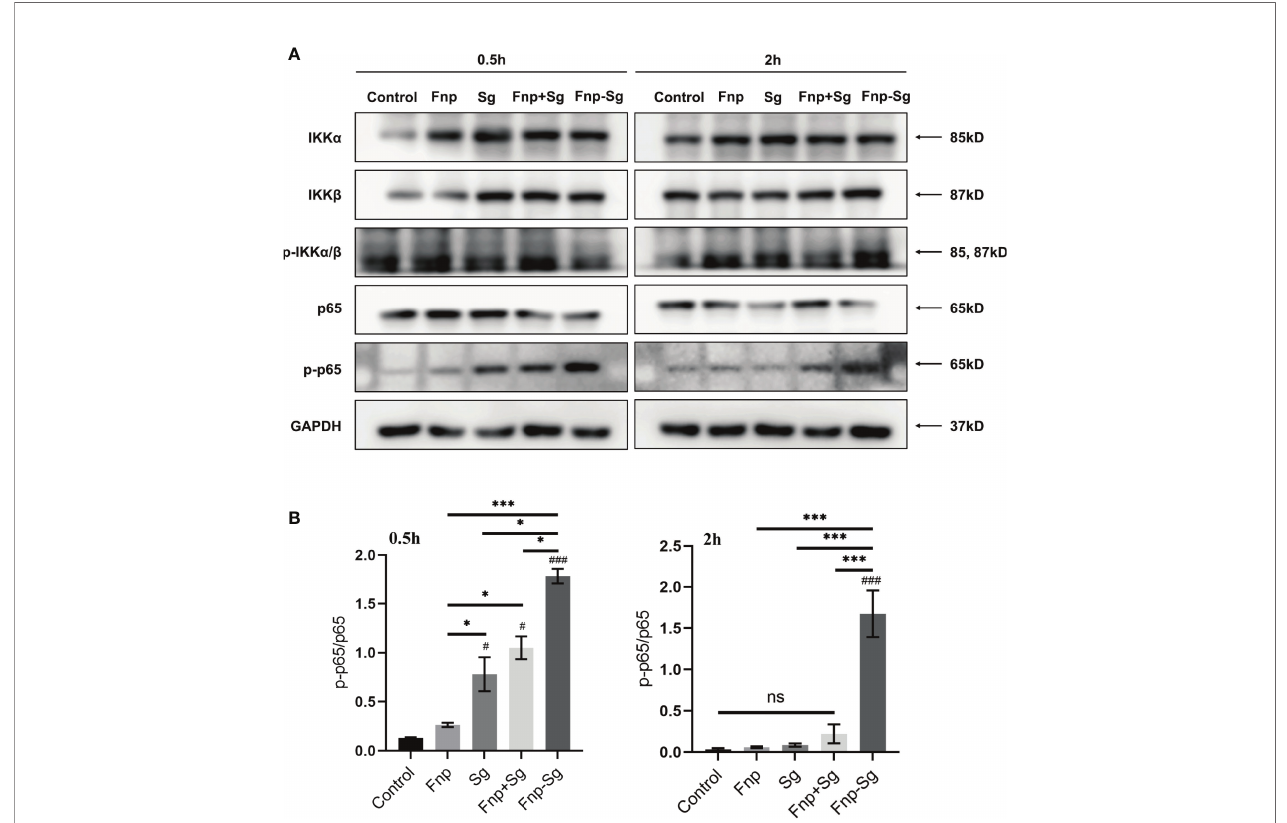
FIGURE 8 | The phosphorylation levels (A) and semiquantitative analysis (B) of proteins in NF- k B signaling pathways in hGECs infected with Fnp, Sg, Fnp+Sg and Fnp-Sg (* p < 0.05 , *** p < 0.001 ; # p < 0.05 , ### p < 0.001 , # compared with the control group; ns: not statistically signi fi